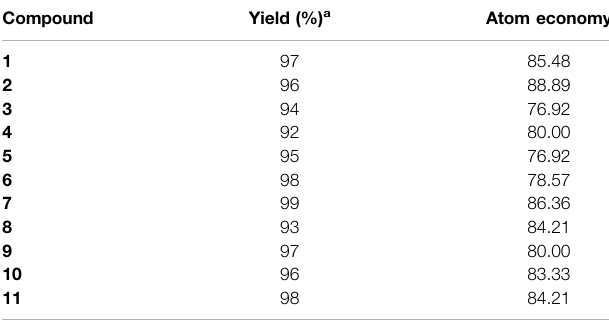
TABLE 1 | The yield, and atom economy in the synthesis of benzopyrazines ( 1 – 11